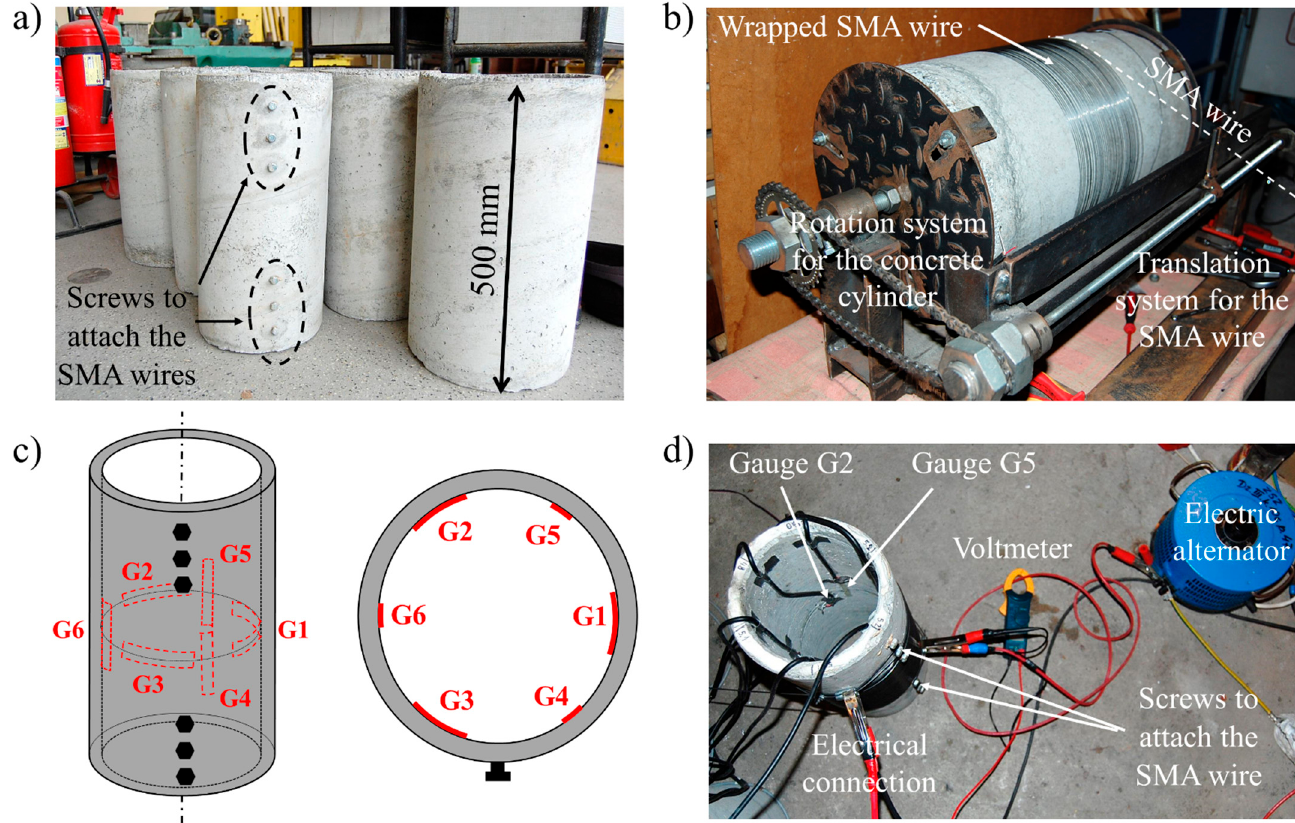
Figure 2. Test details: ( a ) photo of concrete test samples (hollow cylinders) after demolding, with anchoring bolts visible on one sample; ( b ) hand wire-winding machine; ( c ) location of the strain gauges on the internal surface of the concrete cylinders; ( d ) photo of the Joule effect setting for the prestressing of the hollow cylinder.